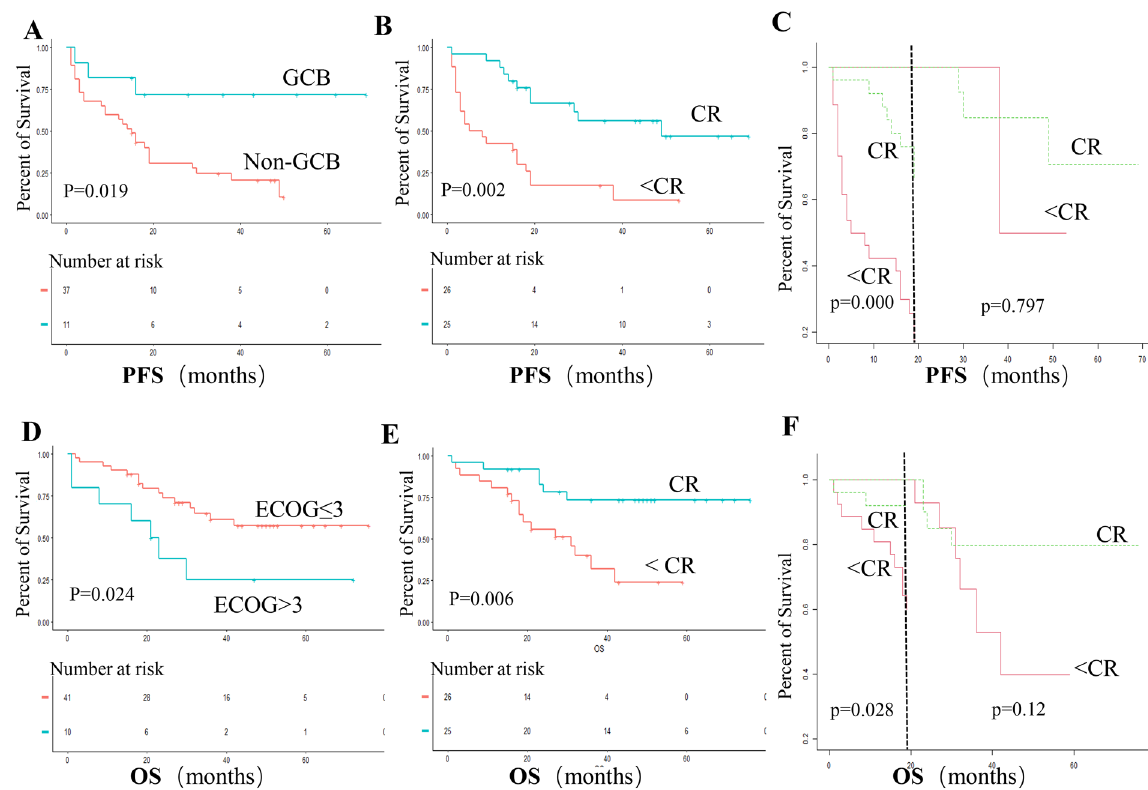
Figure 2. Kaplan–Meier survival curves and landmark analysis. ( A ) Progression-free survival by pathological subtype (GCB vs. non-GCB); ( B ) Progression-free survival by response (CR vs. not CR) at the end of induction chemotherapy; ( C ) Landmark analysis of progression-free survival by response (CR vs. not CR) at the end of induction chemotherapy; ( D ) Overall survival by subtype (ECOG > 3 vs. ECOG ≤ 3); ( F ) Overall survival by response (CR vs. not CR) at the end of induction chemotherapy; ( E ) Landmark analysis of overall survival by response (CR vs. not CR) at the end of induction